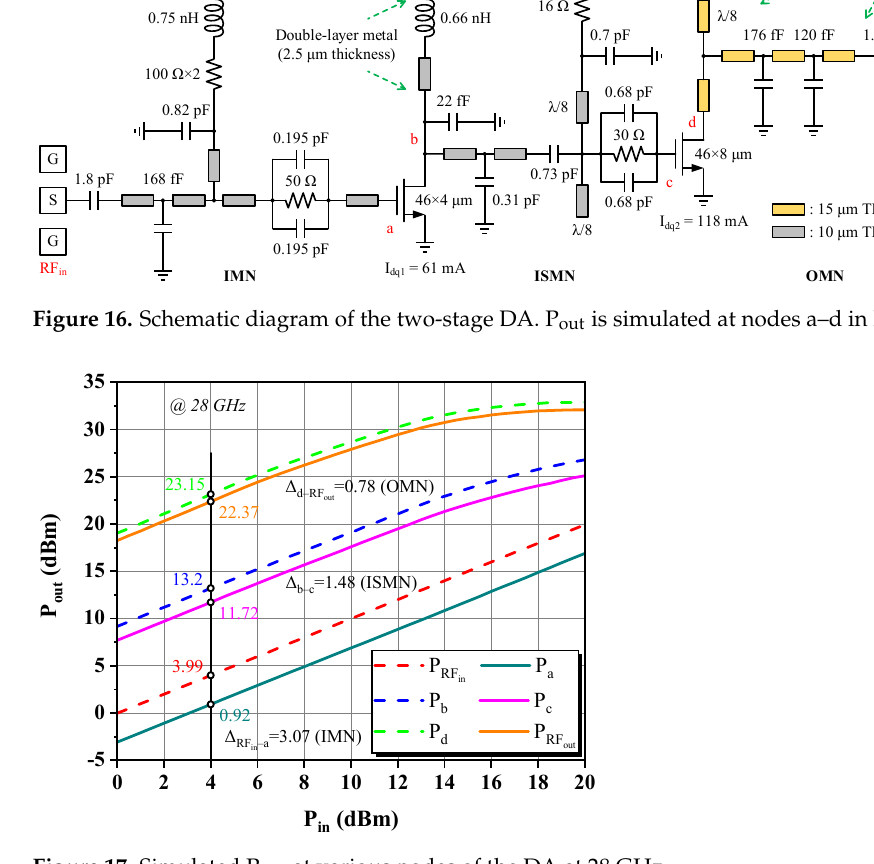
Figure 17. Simulated P out at various nodes of the DA at 28 GHz.